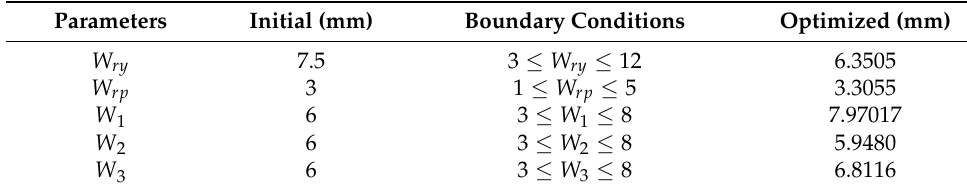
m ) N ( e Figure 9. Torque and ripples ratio w.r.t optimization parameters ( a ) R1 ( b ) W ry ( c ) W1 ( d ) W2 ( e ) W3 ( f ) W r . A v er ag e t o r qu